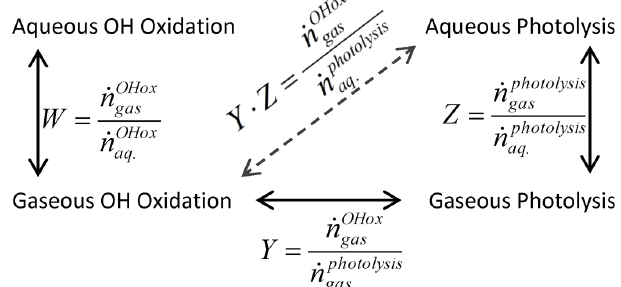
Fig. 1. Schematic diagram detailing the four chemical sinks be- ing investigated in this manuscript. Dotted ˙ n represents the rate of change in moles per time per volume of air parcel due to each of the (cid:16) (cid:17) ˙ n OHox 4 processes: gaseous oxidation by OH , aqueous oxida- gas (cid:16) (cid:17) (cid:16) (cid:17) ˙ n OHox ˙ n photolysis tion by OH , gaseous photolysis , and aque- gas aq . (cid:16) (cid:17) ˙ n photolysis ous photolysis . The ratios of the removal rates W , Z , aq . and Y are defined in the text; they are independent of the air parcel volume. From these three ratios, the relative rates of any of these four processes can be calculated; an example is shown with a bro- ken